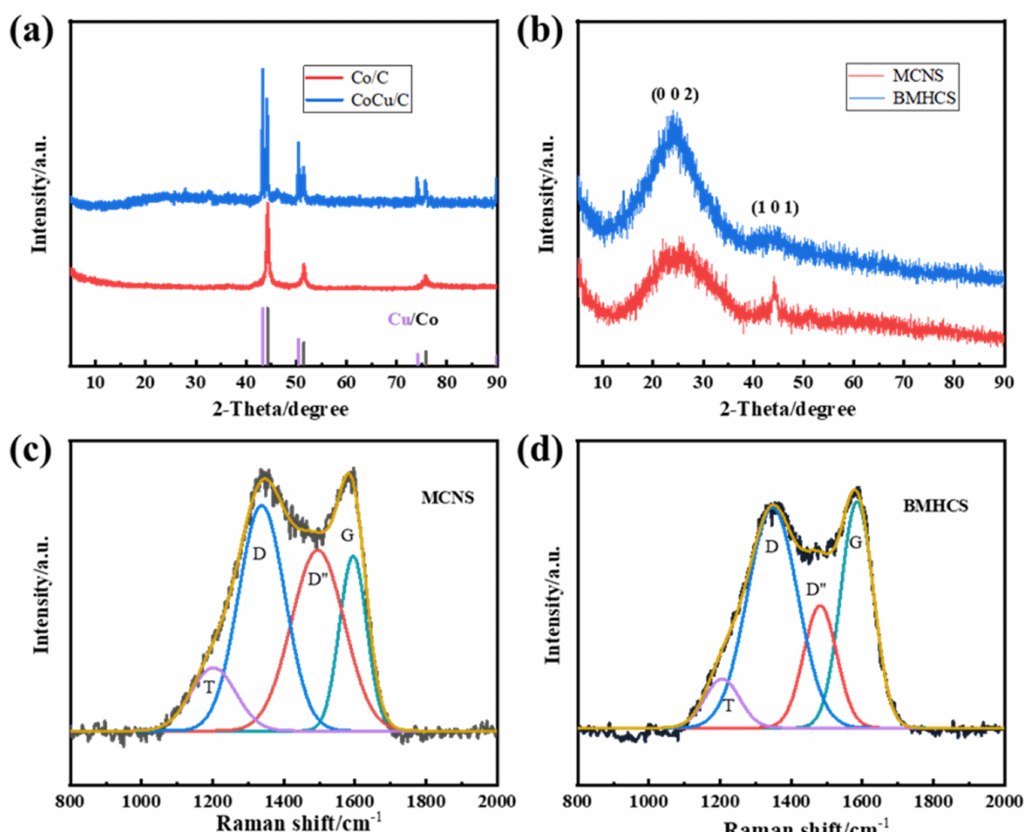
Figure 5. ( a ) XRD patterns of Co/C and CoCu/C; ( b ) XRD patterns of MCNS and BMHCS; ( c ) Raman spectra of MCNS; ( d ) Raman spectra of